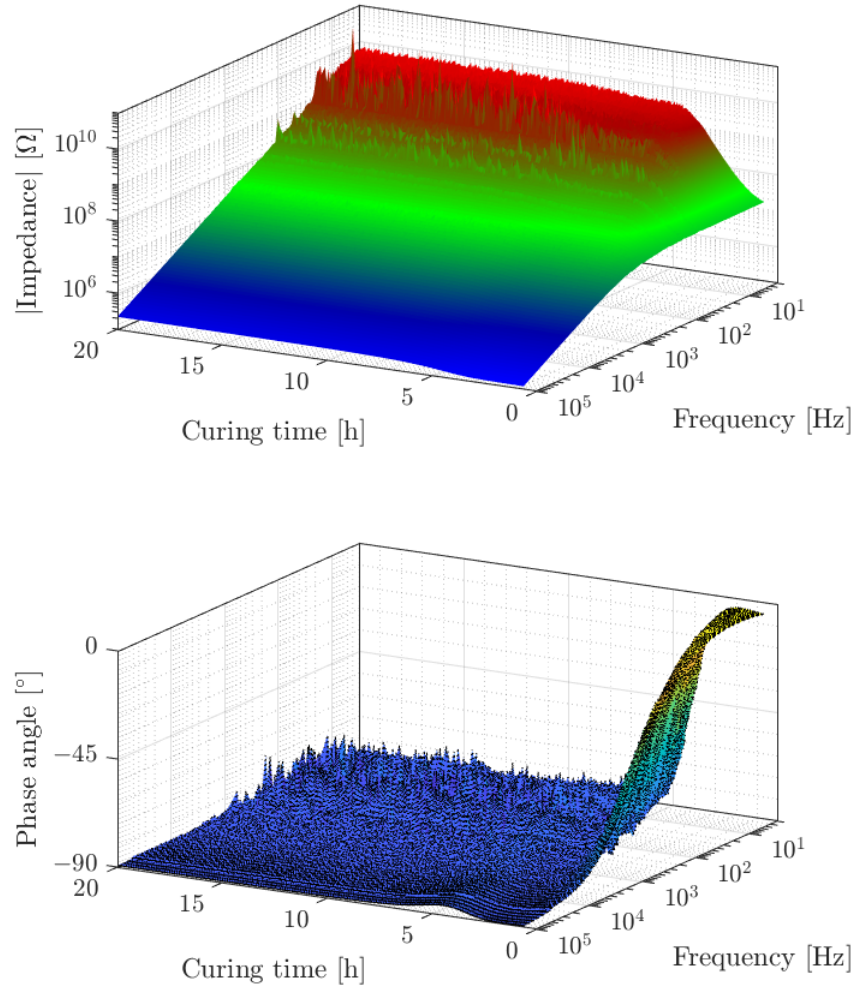
Figure 10. Changes in the electrical impedance of interdigitated electrodes sensors. The upper diagram shows the absolute value of the impedance, and the lower diagram shows the phase angle. The displayed data belong to experiment